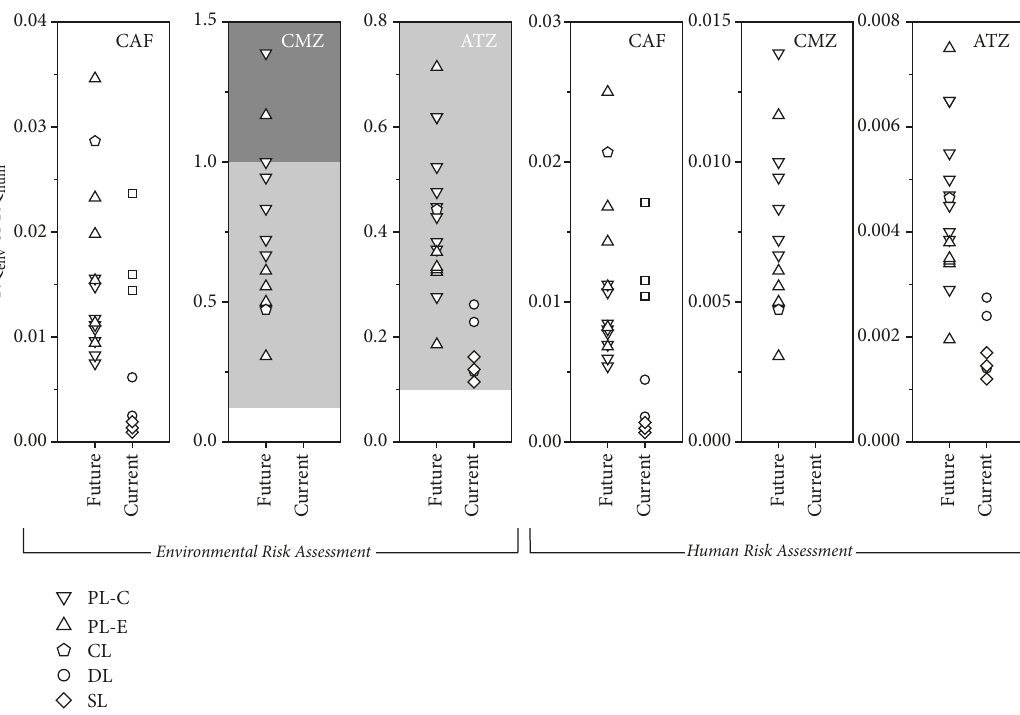
Figure 3: Environmental and human risk assessments of selectedemerging contaminants in future and currentwatersources of the Brazilian Federal District. Dark and light grey regions indicate risk and possible risk, respectively. Blank regions indicate no risk. levels, varying from 3.9 to 15 ng/L, were also similar to